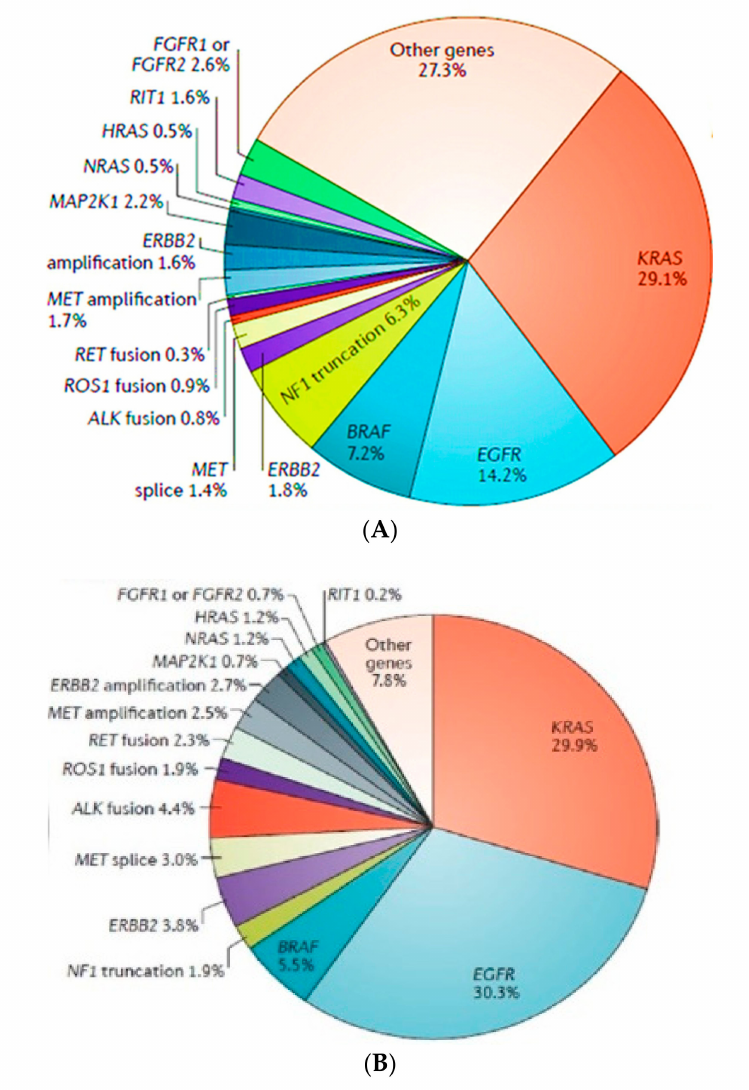
Figure 4. Distribution of the oncogenic driver mutations in non-small cell lung carcinoma (NSCLC) (adapted from Skoulidis F et al., 2019). ( A ) Early stage and ( B ) metastatic disease. The most common oncogenic mutations are deletion in exon 19 (45–50% of all somatic EGFR mutations) and a point mutation (L858R) in exon 21 (35–45% of mutations) [25,36,37]. Ex20Ins mutations are the third-most common EGFR-activating mutations in NSCLC [38], which collectively account for approximately 4% to 10% of all EGFR mutations [35].